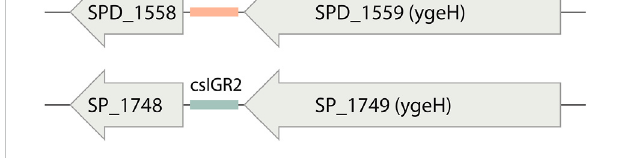
FIGURE 4 The core switched intergenic region (csIGR) in S. pneumoniae D39 and Tigr4. Each type of csIGR is represented in these strains, with D39 having csIGR1 (orange) and TIGR4 having csIGR2 (green). In D39, csIGR1 is fl anked by SPD_1558 and SPD_1559. In TIGR4, csIGR2 is fl anked by the genes SP_1748 and SP_1749.